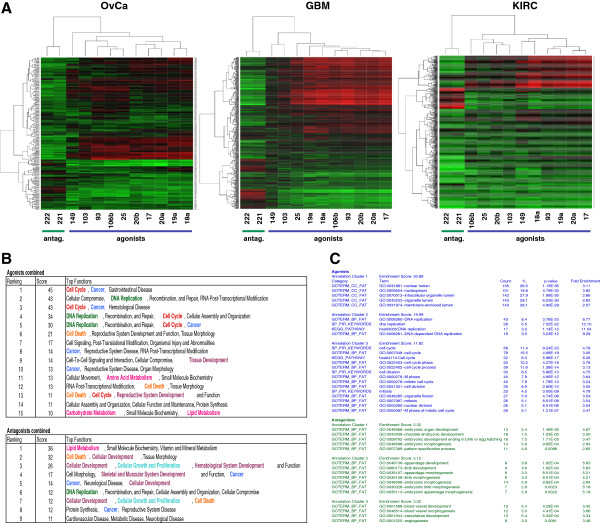
Functional analysis of genes correlating with agonistic and antagonistic miRNA clusters. (A) Heat maps displaying nonhierarchical unsupervised cluster analyses of the sPCC values derived by comparing the expression of 10 agonistic and 2 antagonistic miRNAs with the combined genes of the 6 oncogenic signatures listed in Figure 4A (data are found in Additional file 13: Table S12). (B) IPA network analysis of the combined genes (from the 6 oncogenic gene signatures) that positively correlated with the agonistic miRNAs (upper panel) or antagonistic miRNAs (lower panel). (C) DAVID gene ontology analysis of the same genes analyzed in B. Lists of genes used for these analyses can be found in Additional file 11: Table S10.